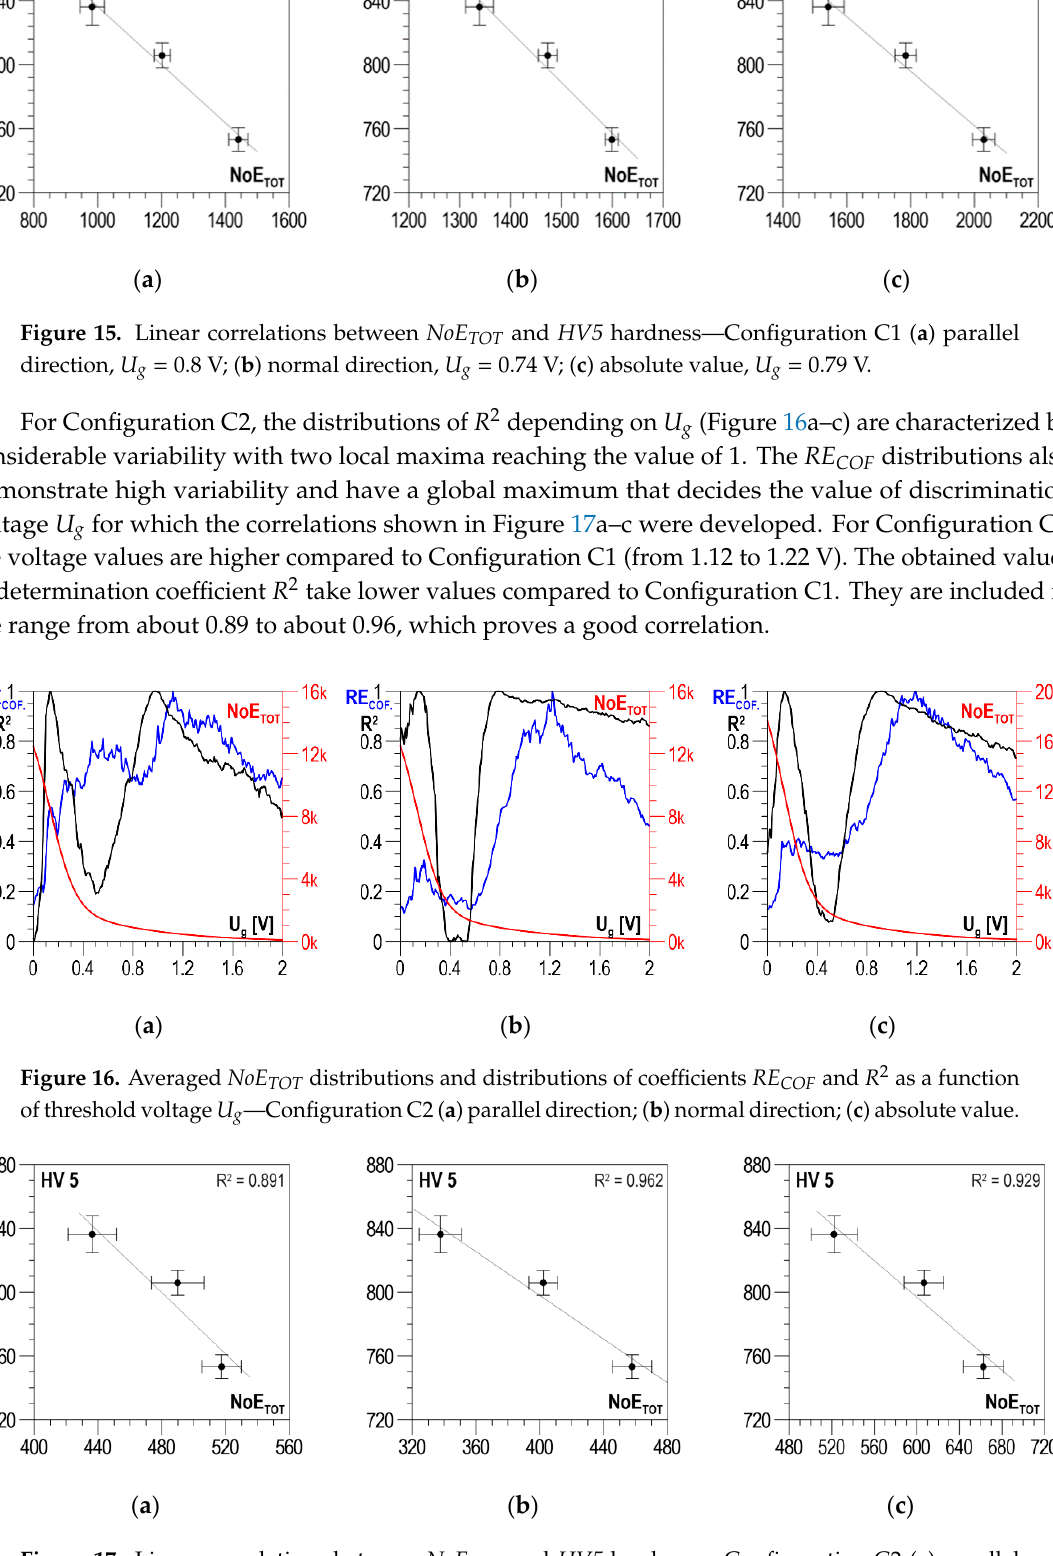
Figure 14. Averaged NoE TOT distributions and distributions of coefficients RE COF. and R 2 as a function of threshold voltage U g —Configuration C1 ( a ) parallel direction; ( b ) normal direction; ( c ) absolute value.